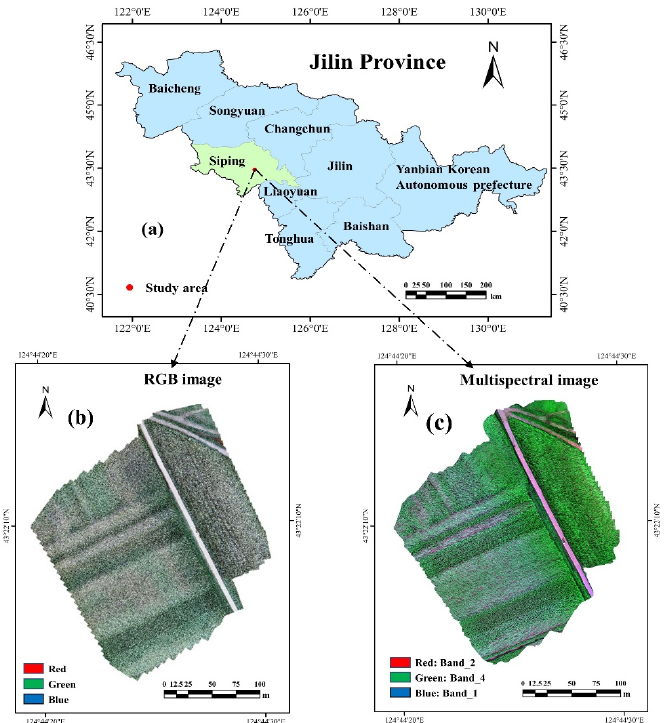
Figure 2. Overview of the study area ( a ) Geographical location of the study area. ( b ) The UAV RGB image. ( c ) The UAV multispectral image (false color composite, R: Red, G: NIR, B: Green).